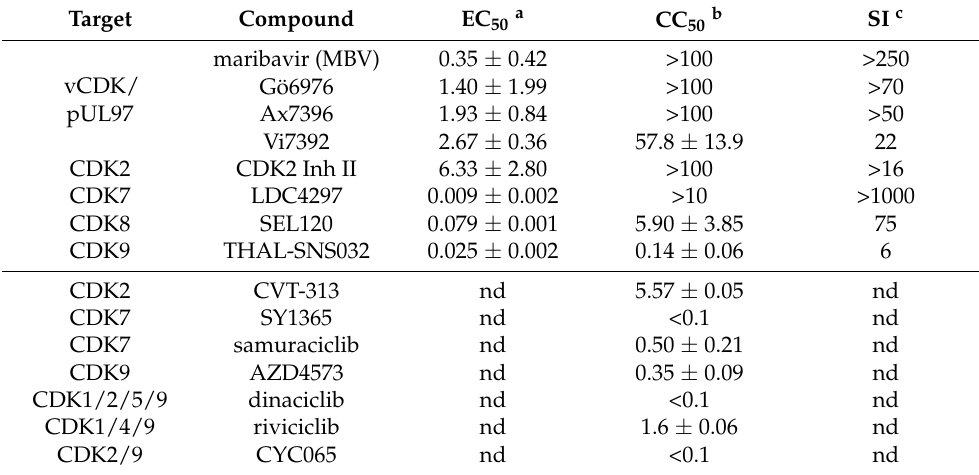
Table 1. Single treatments: anti-HCMV-specific EC 50 , HFF-specific CC 50 and SI values of selected